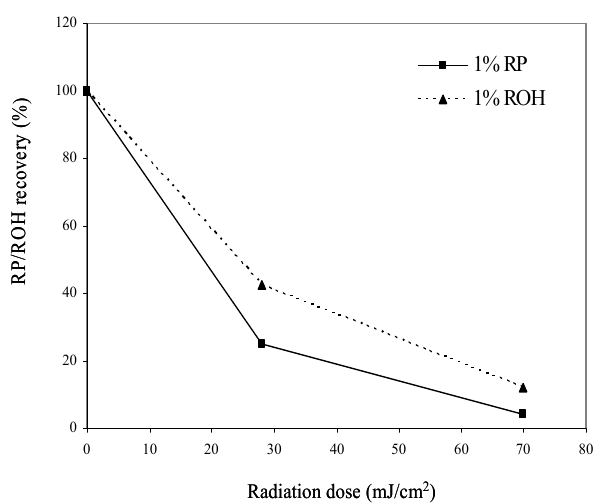
Figure 3 : Photodecomposition of RP and ROH.